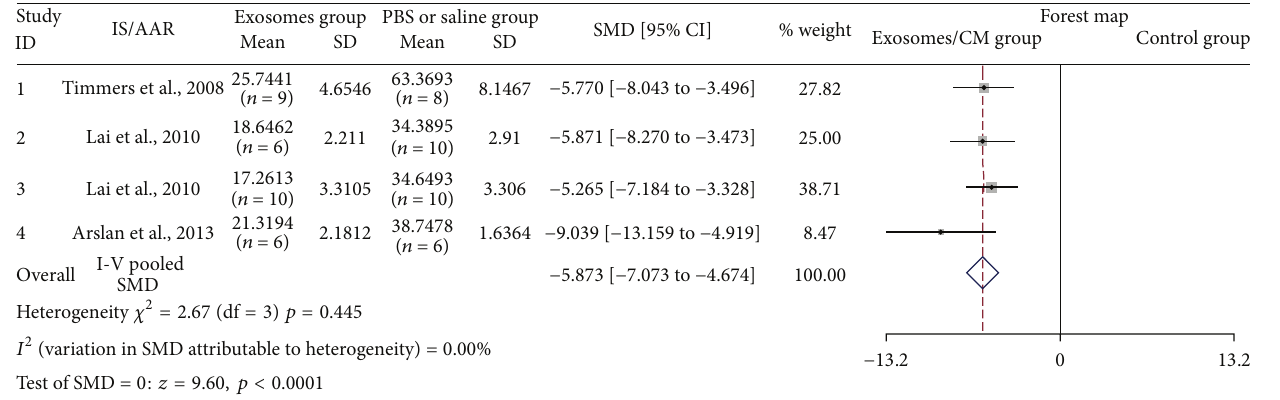
Figure 3: The effectiveness of exosomes on